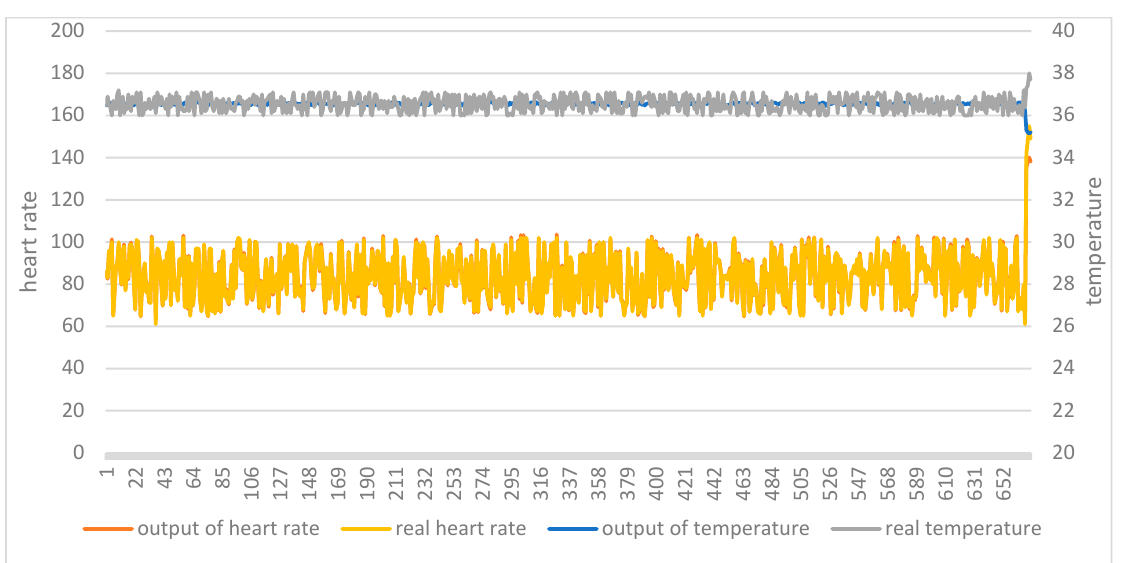
Figure 14. Comparison of input and output of GRU-AE model in test set 1.